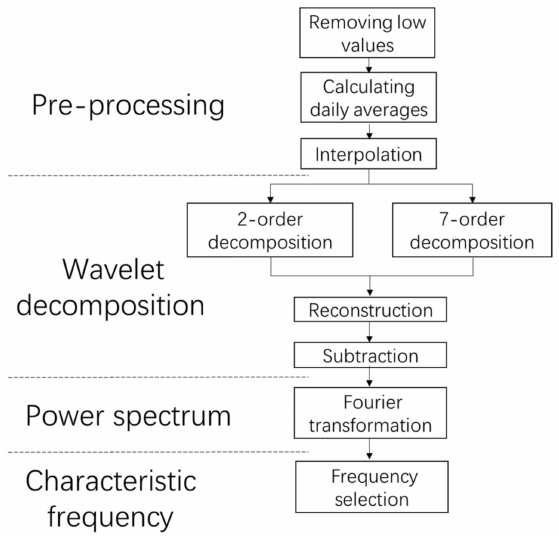
Figure 4. Flow chart of anomaly extraction